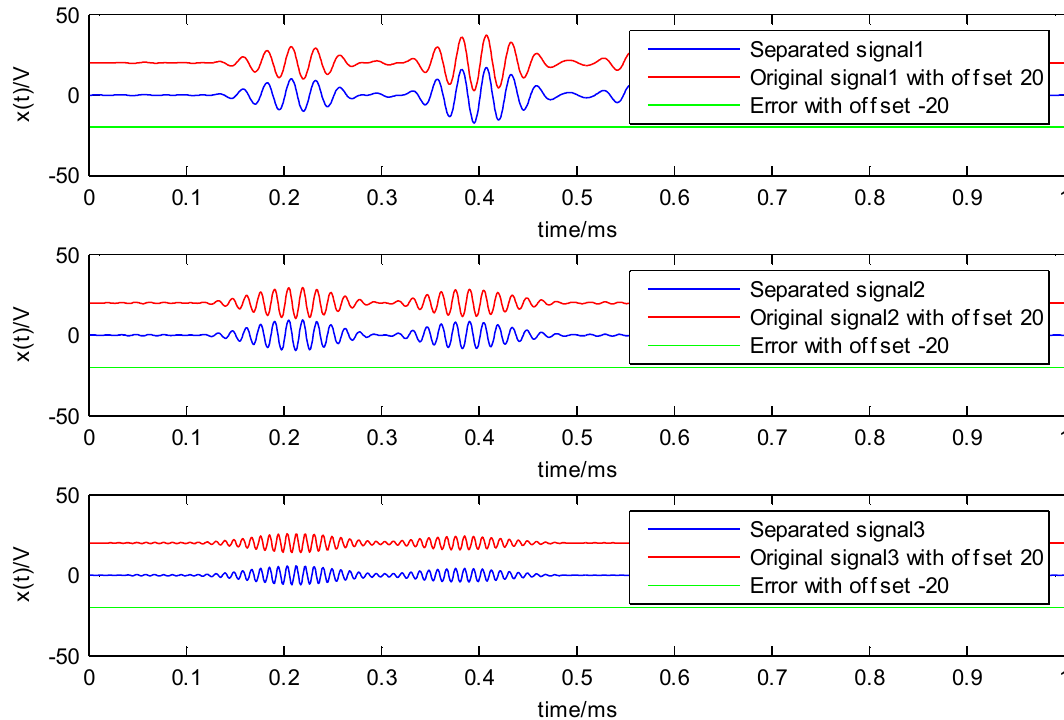
Figure 8. Decomposition signals of the proposed LWM-EWT method: the red curves are the original signals (with offset of 20 V); the blue curves are the separated signals and the green curves are the error (with offset of −20 V) between separated signals and original signals.